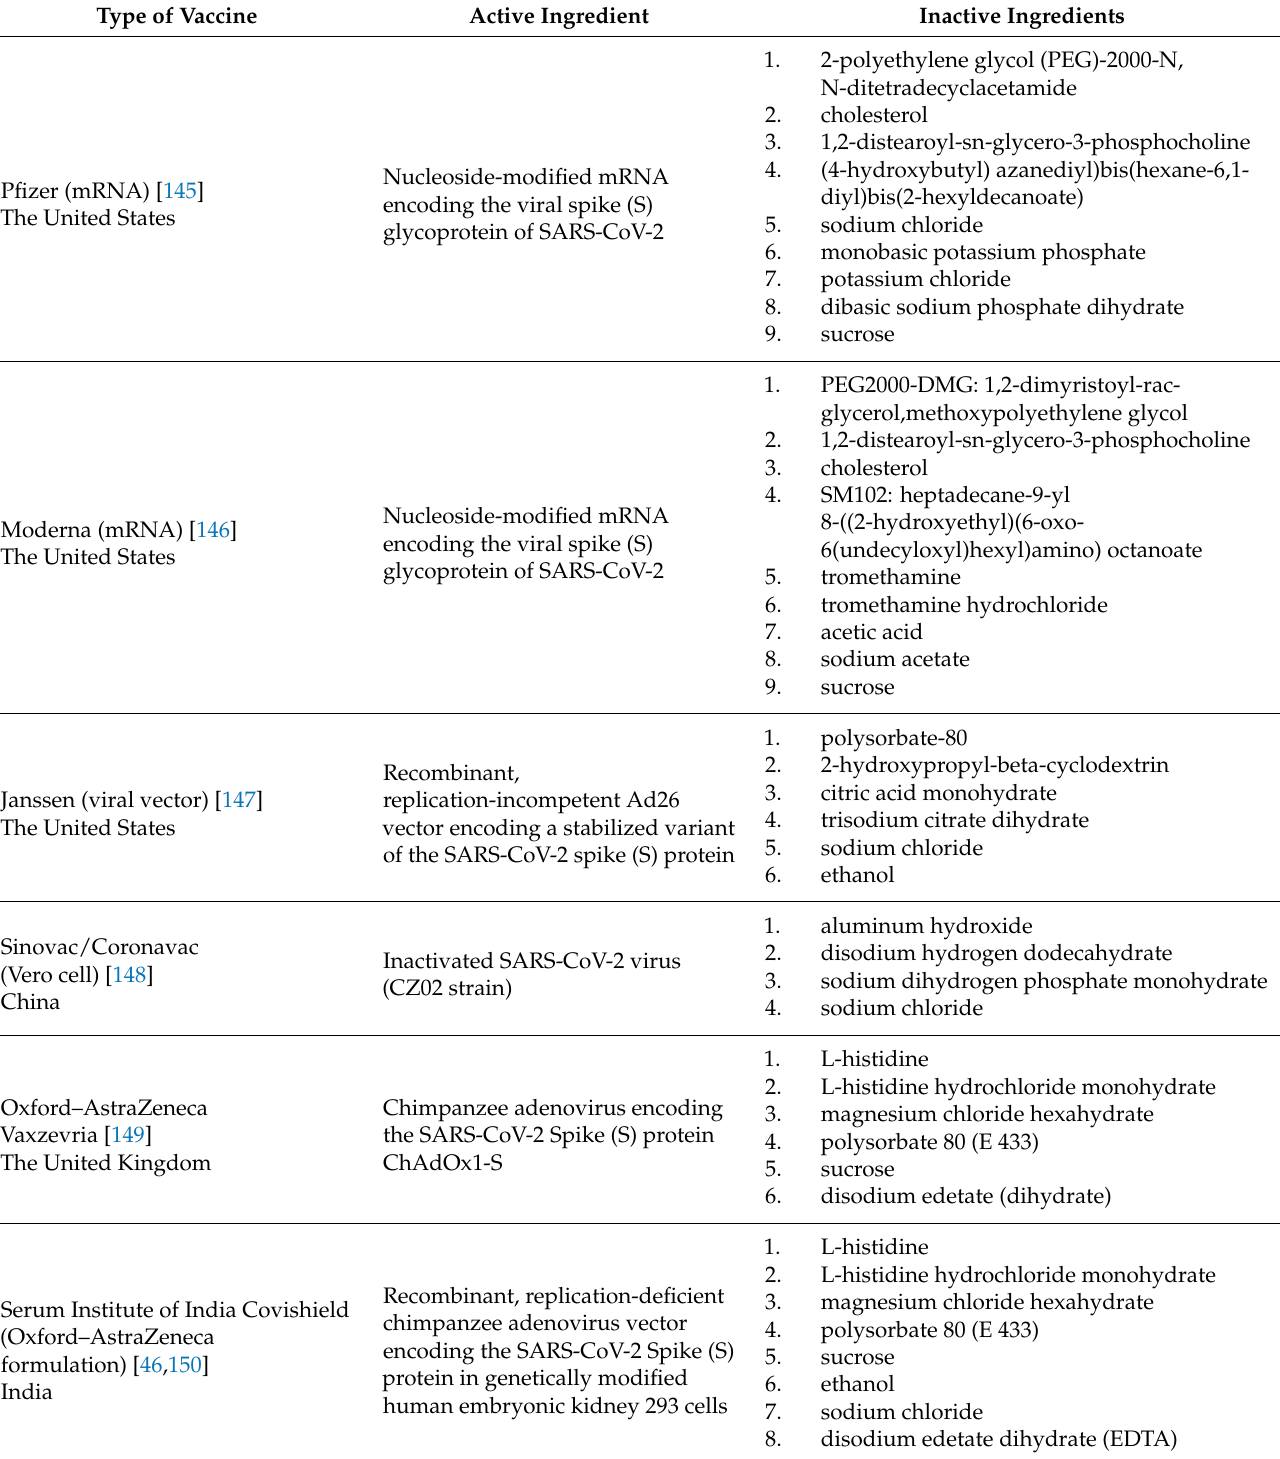
Table 2. Components of 24 COVID-19 vaccines with emergency use authorizations by national regulatory authorities (as at 13 September 2021). The first 7 vaccines on the table have been approved for emergency or full use by at least one WHO-recognized stringent regulatory authority (Pfizer, Moderna, Janssen, Sinovac, Oxford–AstraZeneca, Serum Institute of India Covishield, Sinopharm-BBIBP). The remaining vaccine candidates were arranged in alphabetical order. Type of